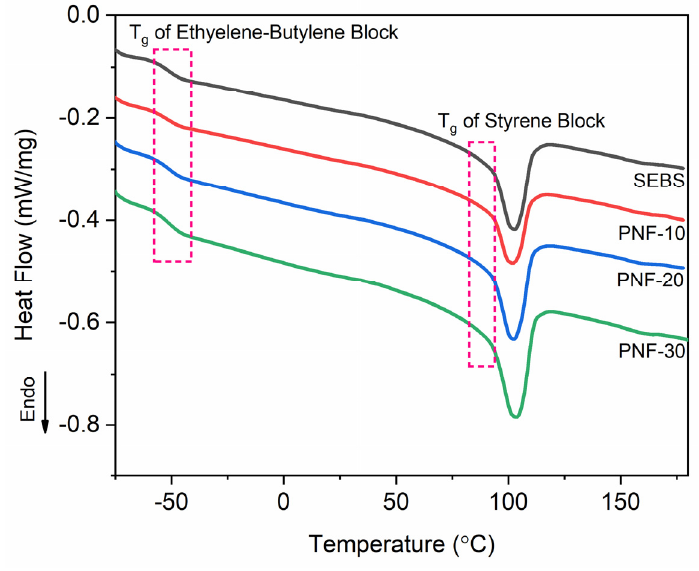
Figure 8. DSC thermograms of the composites.